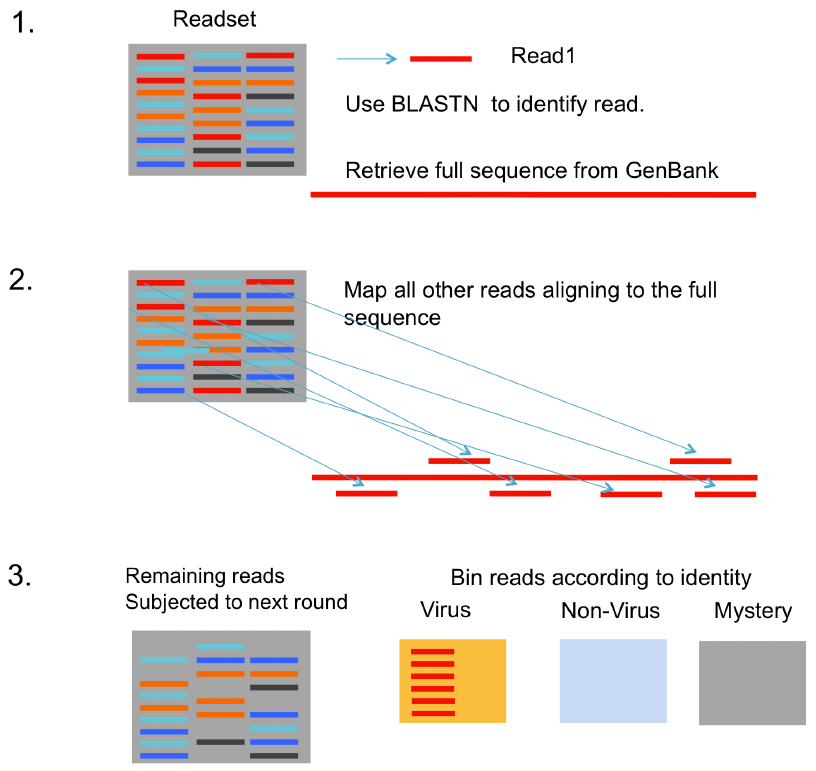
Figure 2. An overview of the SLIM read classification process.